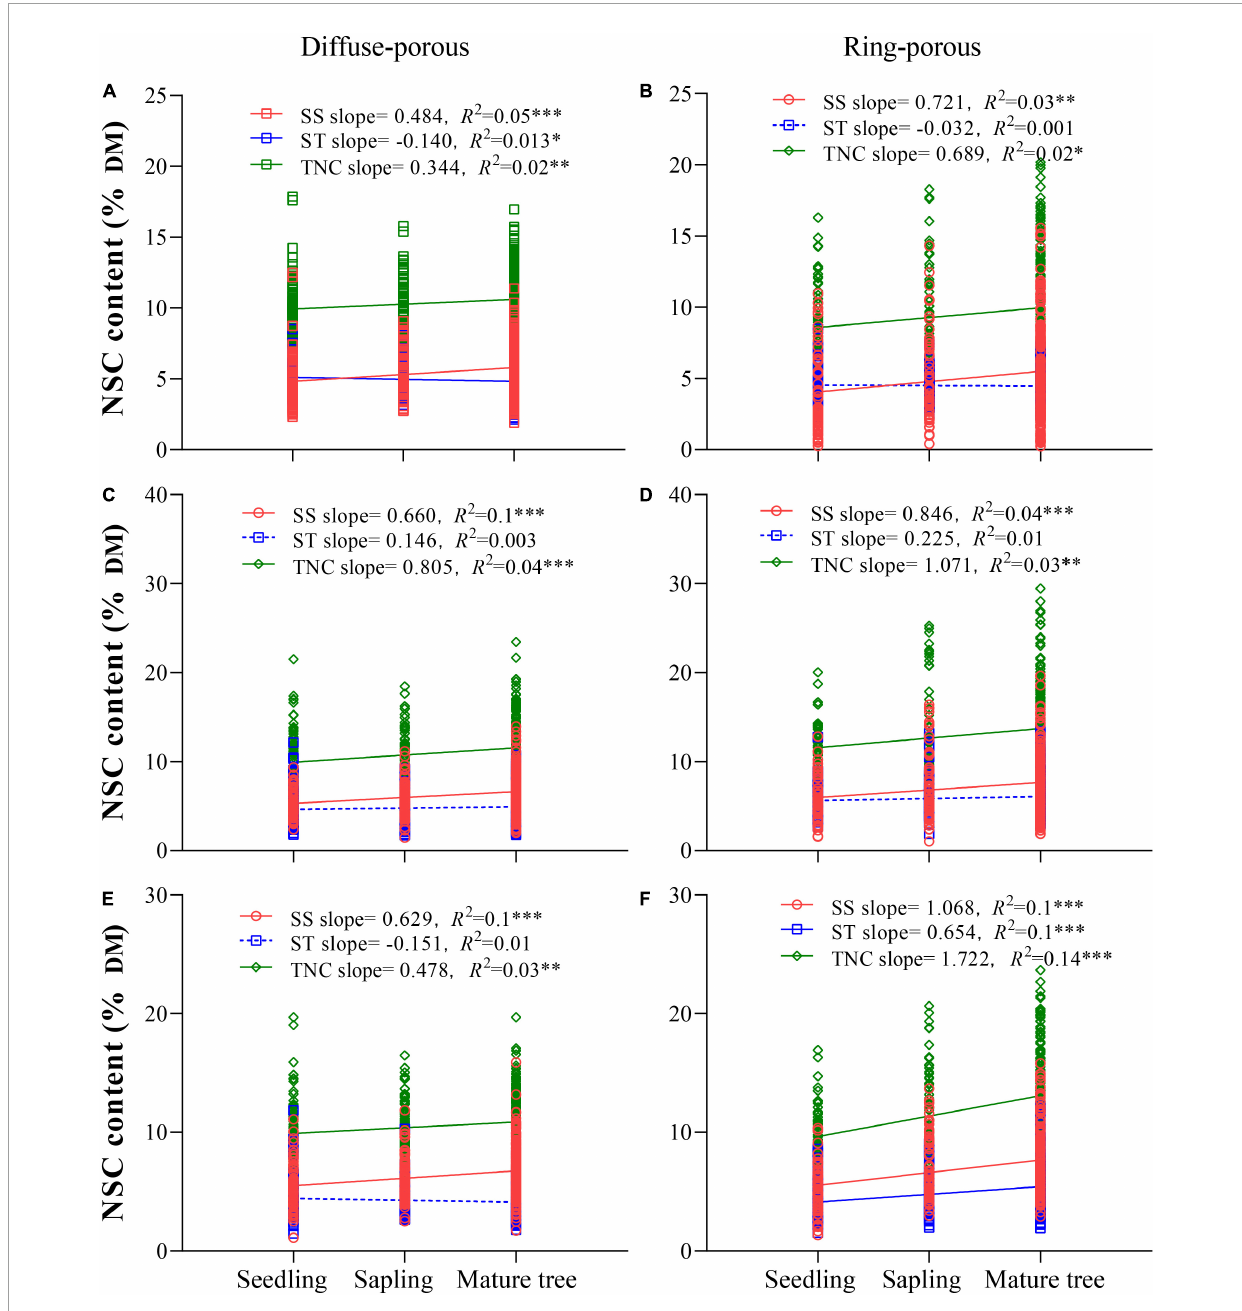
FIGURE3 Variations of non-structural carbohydrates (NSC) components with life history in different organs of diffuse-porous and ring-porous species. (A,B) Shows leaf composition; (C,D) shows new twig composition; (E,F) shows old branch composition. The dashed lines indicate non-significant variation. ∗ p < 0.05, ∗∗ p < 0.01, ∗∗∗ p <